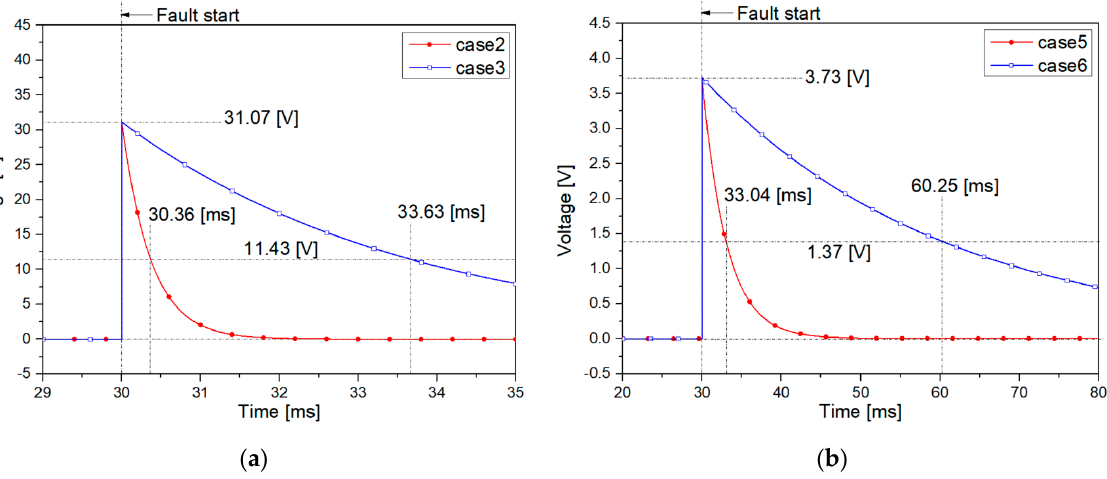
Figure 13. Voltage of the fault point when a fault resistance of 10 Ω occurred ( a ) Resistance used in the mid ‐ point ground is 100 Ω ; ( b ) Resistance used in the mid ‐ point ground is 1000 Ω .